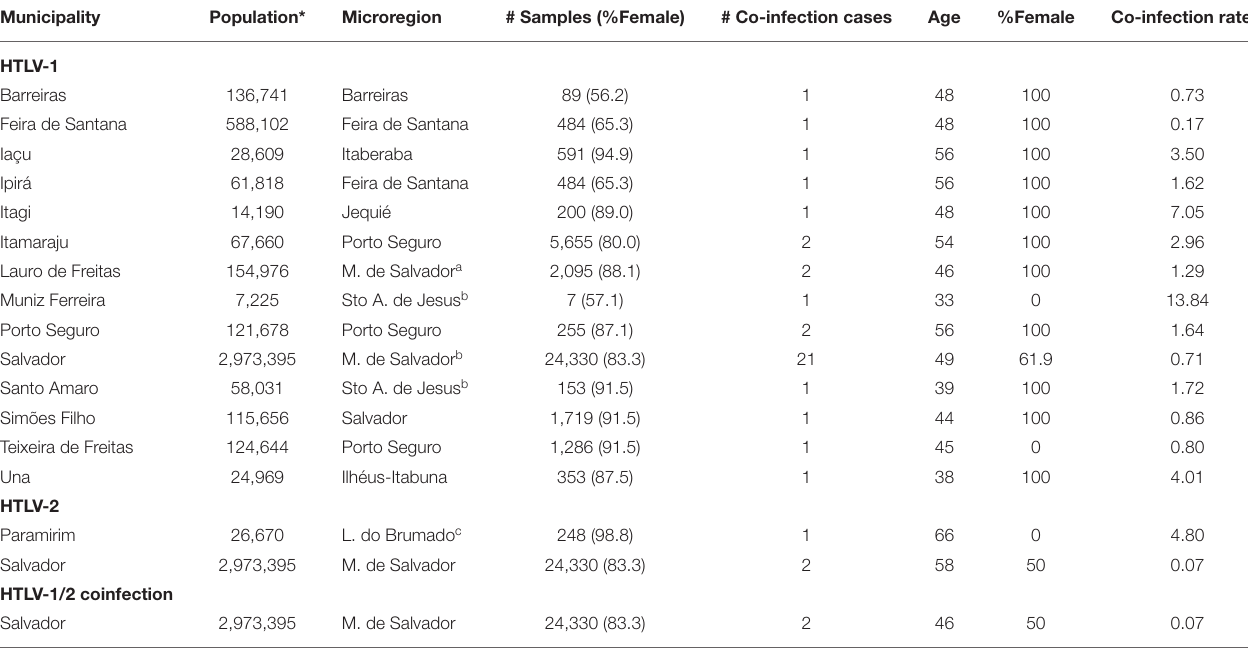
TABLE 1 | Profile of HTLV/HIV coinfection in municipalities throughout Bahia, Brazil (2004–2013). Municipality